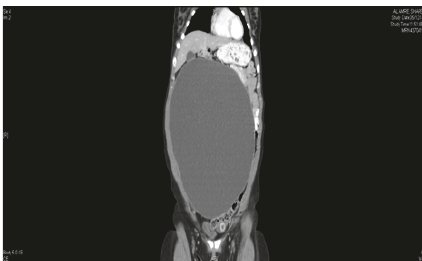
Figure 1: Abdominopelvic computed tomography (CT) showing a large well-defined homogeneously cystic lesion originates from the right ovary measuring 15.6 × 26.3 × 31.7 cm.